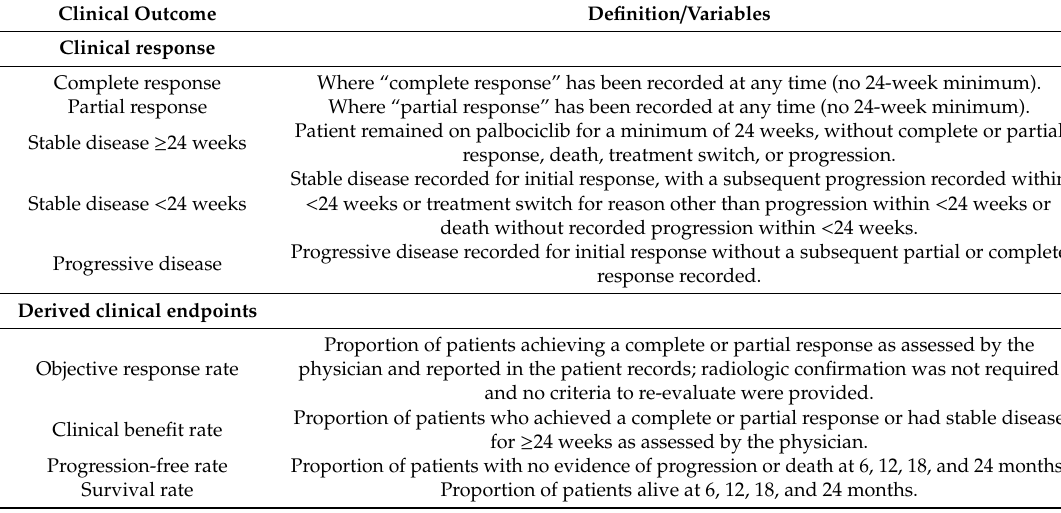
Table 1. Clinical outcome